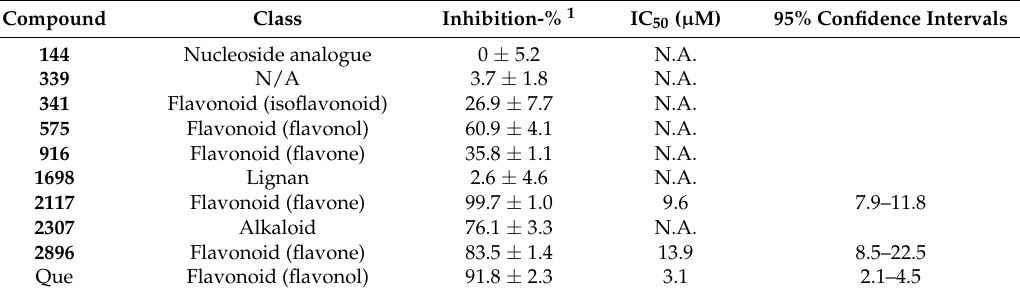
Table 2. Inhibition-% of violacein production by the highly active compounds at 40 µ M and IC 50 values of the leads with 95% confidence intervals. Results are reported as mean ± standard deviation (SD) of three independent tests. N/A = not applicable, N.A. = not analyzed, Que = quercetin. The IUPAC names of the compounds are listed in Table